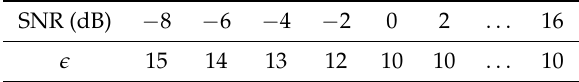
Table 3. (cid:101) with respect to different